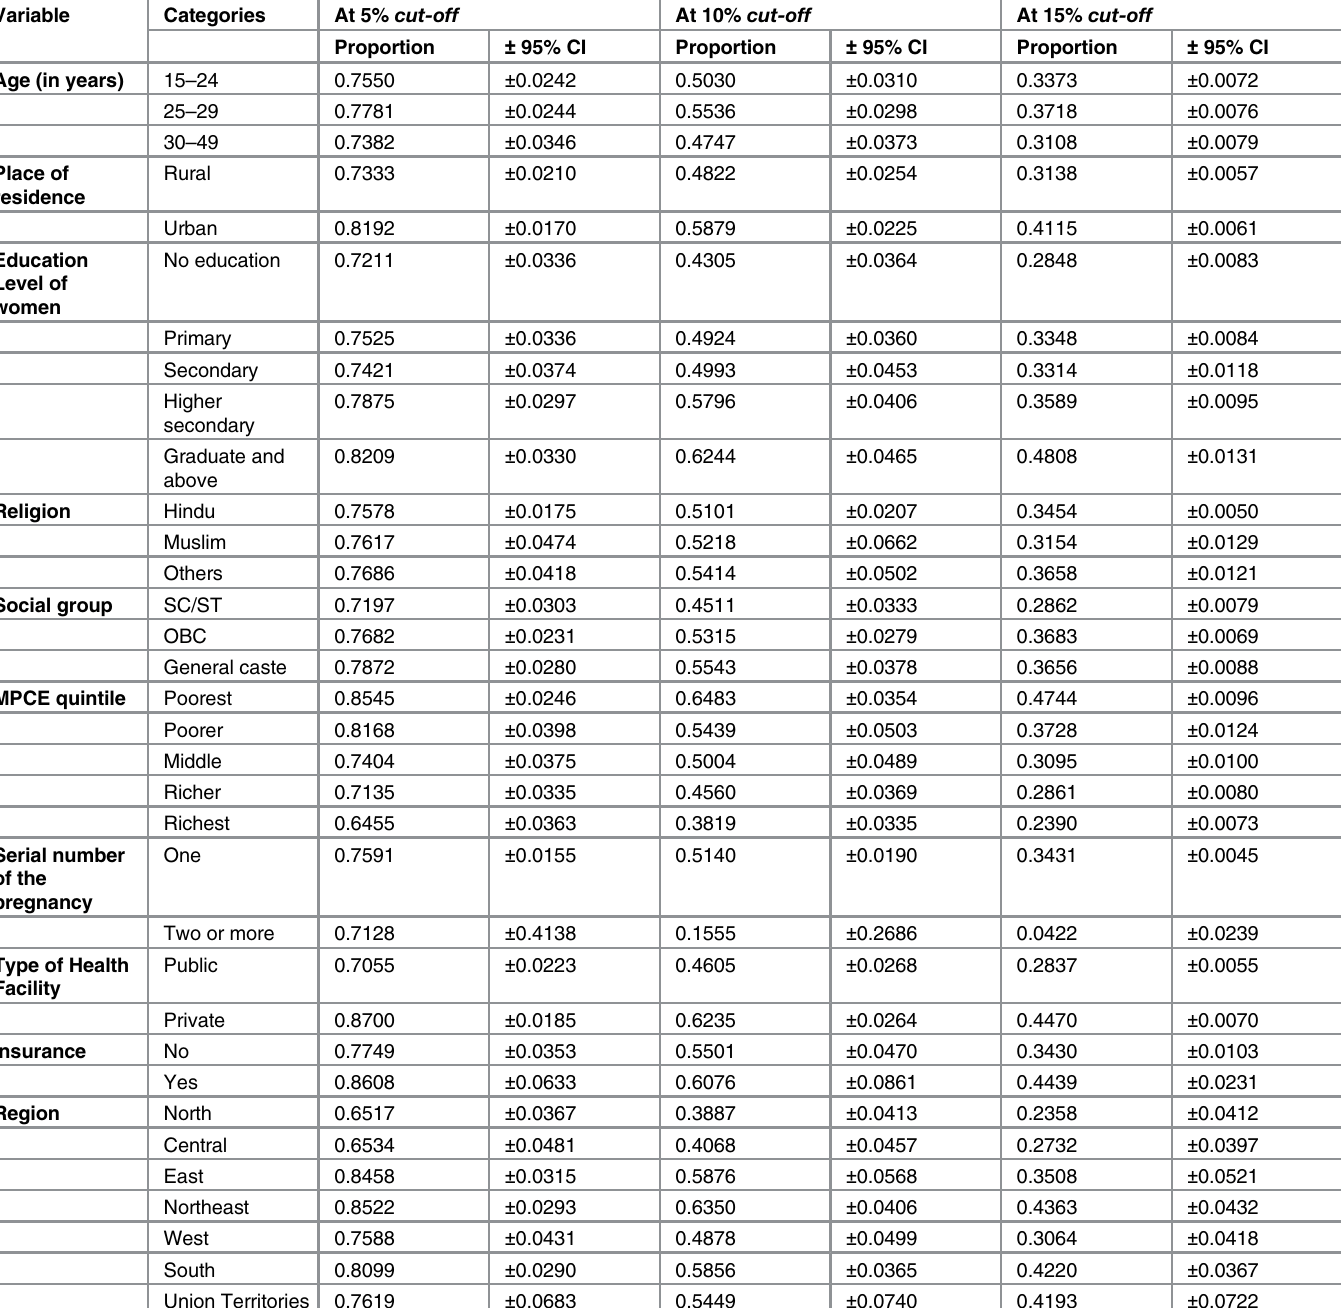
Table 3. Percentage share of total maternity expenditure in annual household consumption expenditure by different cut-offs and background characteristics (n =